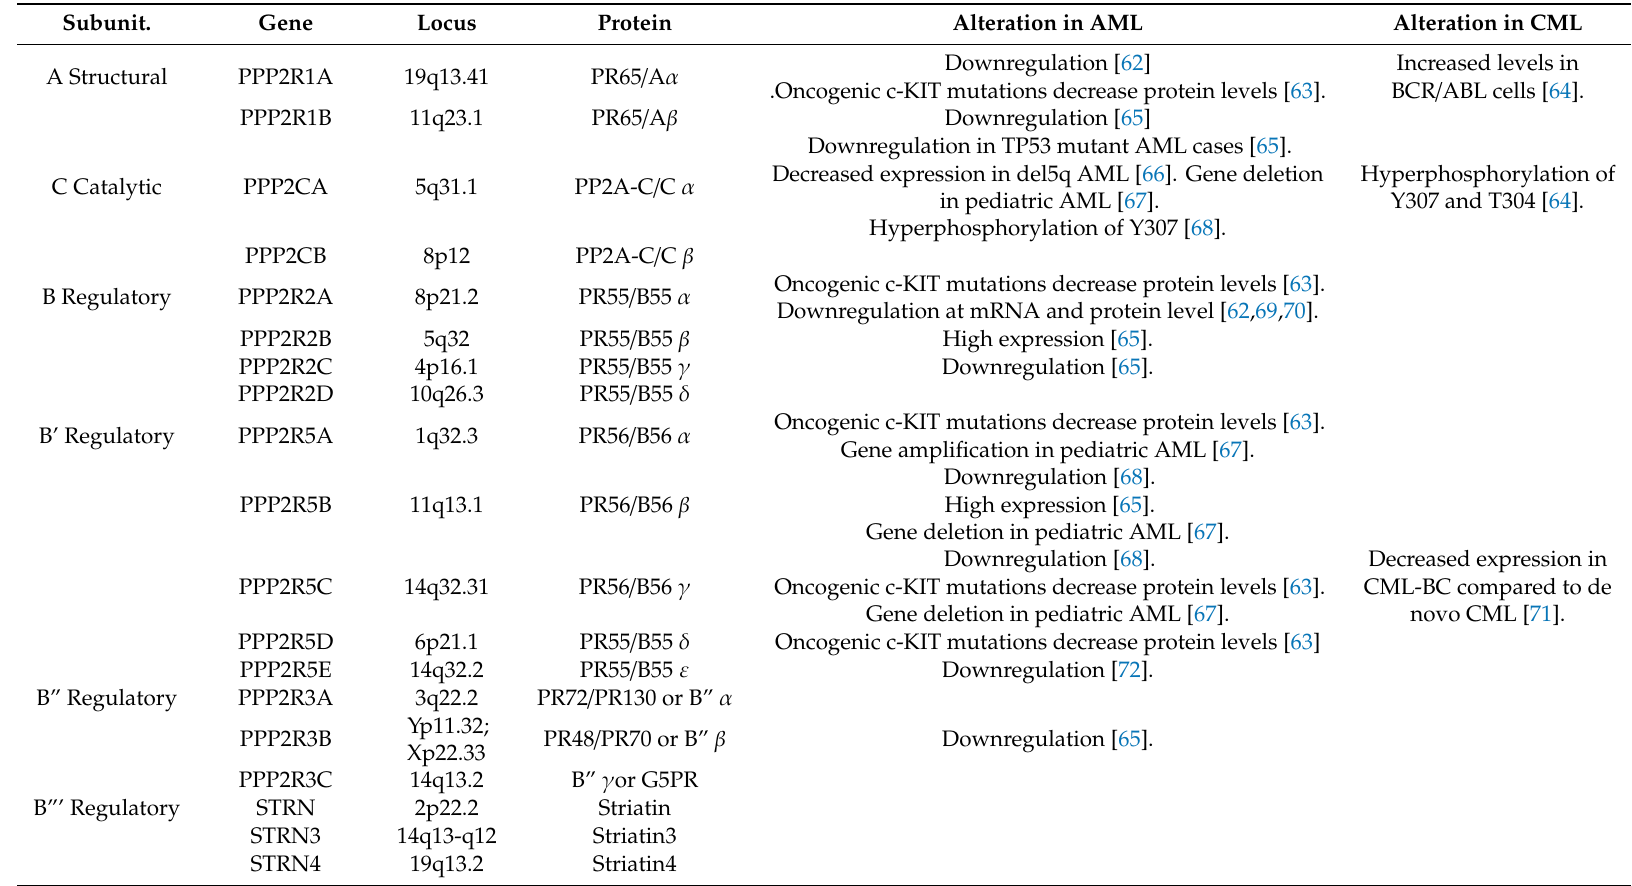
Table 1. PP2A subunits and reported alterations in acute myeloid leukemia (AML) and chronic myeloid leukemia (CML).